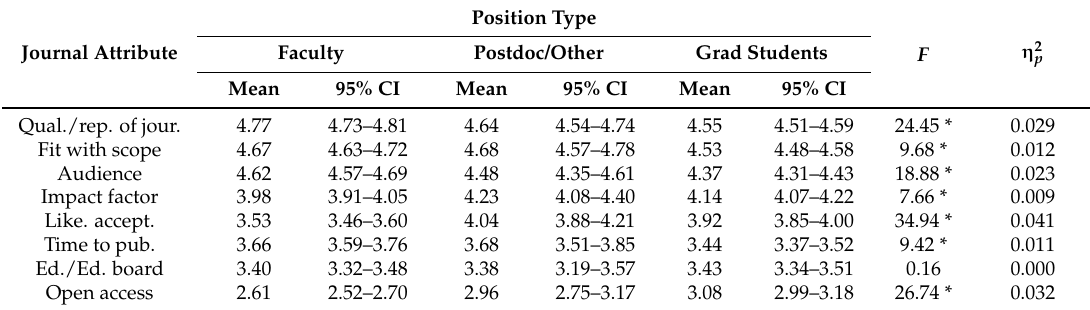
Table 4. Importance of journal attributes by position.